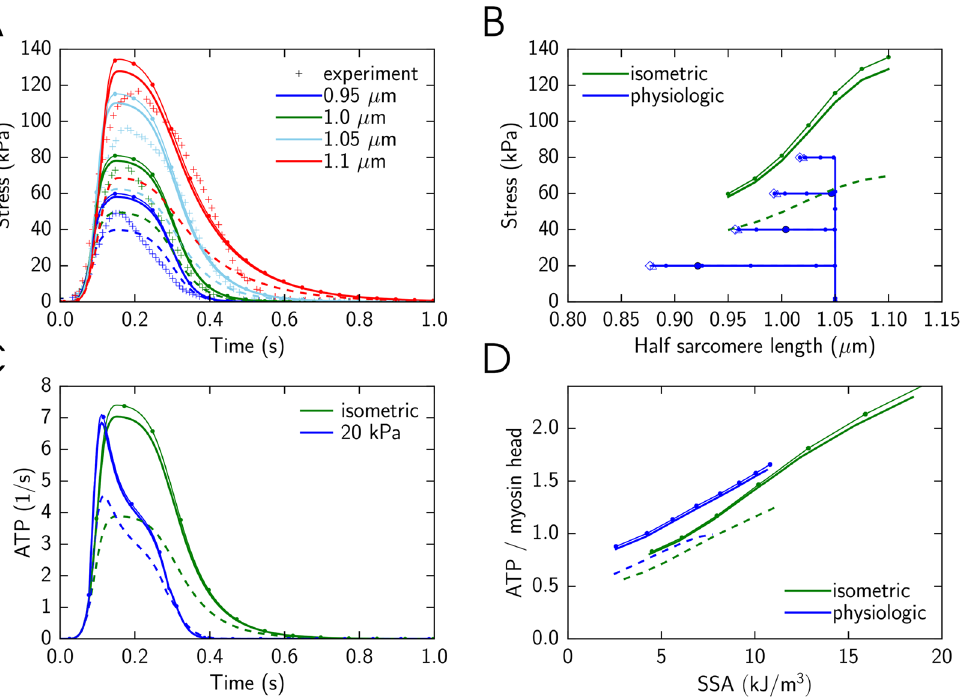
Fig 5. Influence of cross-bridge interaction on force generation and contraction. Here, the number of interacting cross-bridges was varied from one cross-bridge between the fixed ones ( q = 1), to three and four ( q = 3 or 4, respectively) active cross-bridges. The simulations were performed with the same model parameters, found by fitting for the model with q = 3. The subplots are as in Fig 3, with the addition of one more solution ( q = 4) marked by line with dots and the end-systolic value indicated by diamond. Due to lack of influence from the neighboring binding state to free energy profiles, developed stress at the case where q = 1 is significantly lower than other two cases. Simulation results for q = 3 and q = 4 are similar and sometimes overlapping in the